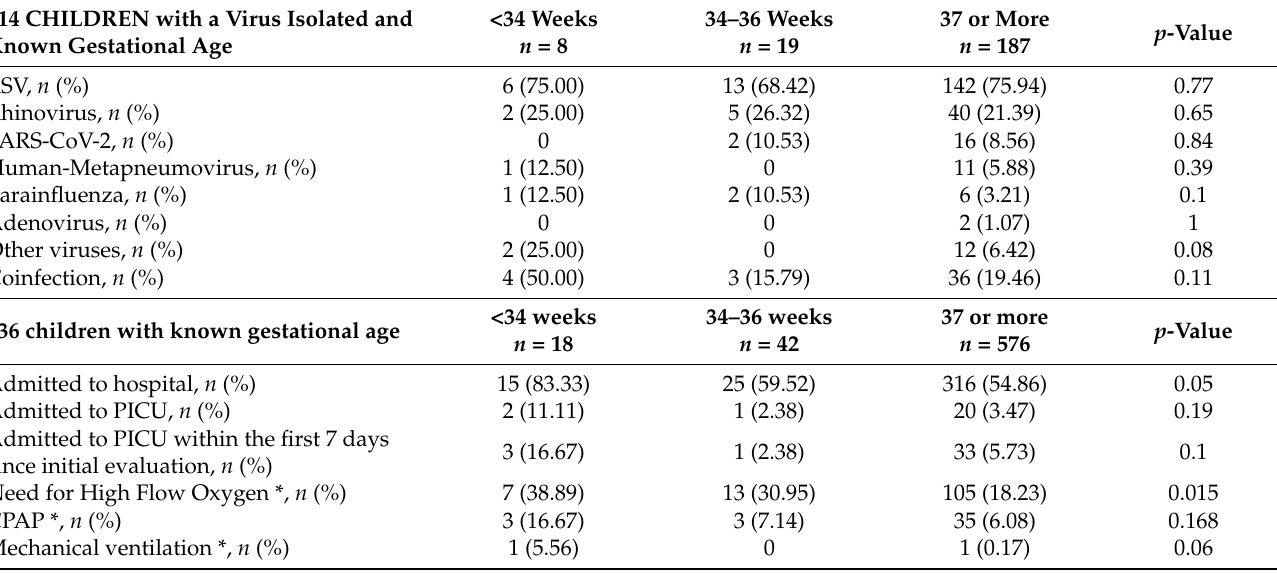
Table 6. Disease severity according to gestational age. CPAP, continuous positive airway pressure; HFNC, high-flow nasal cannulae; PICU, pediatric intensive care